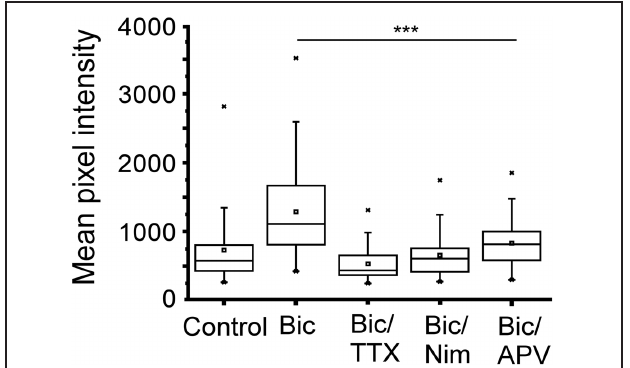
FIGURE 7 | Increase in Cycs CRE − enhancer-driven GFP expression by bicuculline is dependent on NMDA and L-type calcium channel activation. Box and whisker plots showing the relative levels of GFP expression in neurons infected with the CRE − reporter virus after adding bicuculline, bicuculline/TTX, bicuculline/nimodipine (10 μ M), or bicuculline/APV (50 μ M) for 48h. Images of at least 25 cells in 10 fields were analyzed. Mean pixel intensities are in arbitrary units. Between group statistical significance was determined using the paired sample Wilcoxon signed rank test, ∗∗∗ p < 0 .